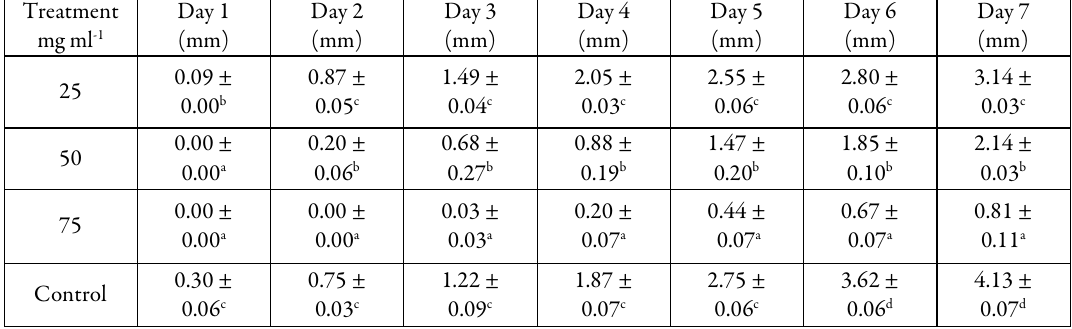
Table 4. In vitro inhibitory effect of M. oleifera aqueous leaf extract on the mycelial growth of R. solani Treatment